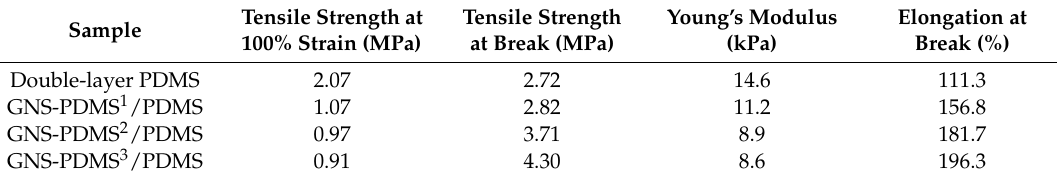
Figure 4. Tensile stress-strain curves of the films. Table 2. Mechanical properties of the films